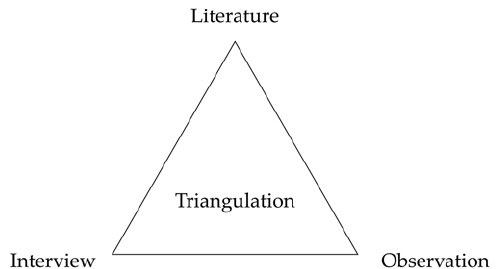
Figure 2. Data triangulation employed in the study.